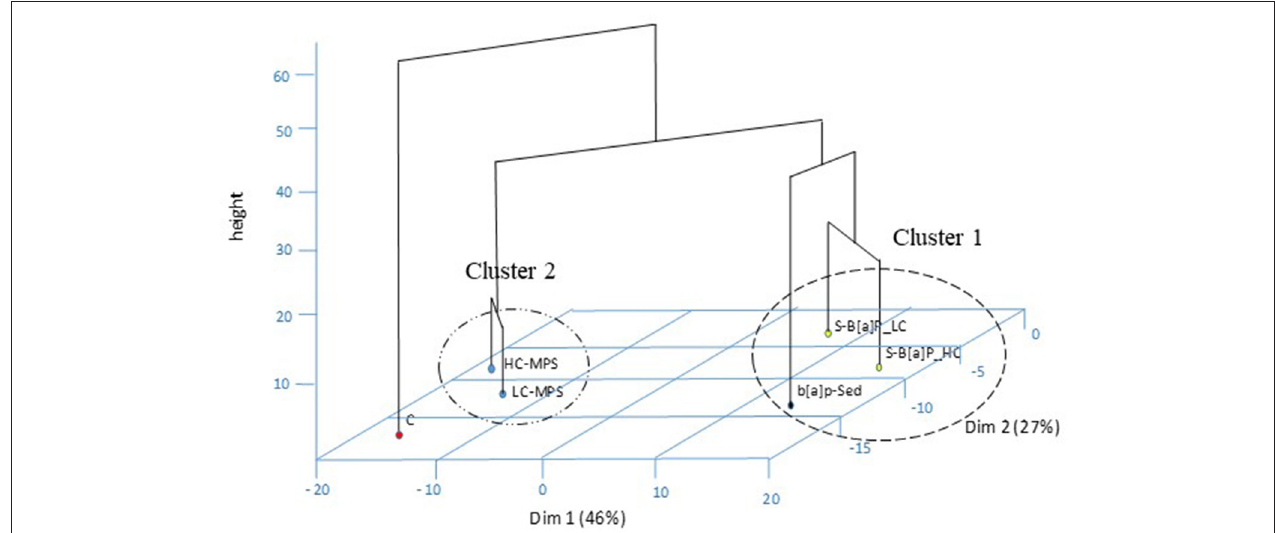
FIGURE 5 | Principal Component Analysis and hierarchical clustering on chemical and biological data in ragworms exposed to various microplastics treatments: uncontaminated sediments (C), D sediments spiked with 1 mg/L B[a]P (S-B[a]P), sediments spiked with 200 and 2000 particles/kg virgin PVC (LC-MPS, HC-MPS) and sediments with B[a]P spiked microplastic particles (B[a]P-LC: 200 particles/kg.; B[a]P-HC: 2000